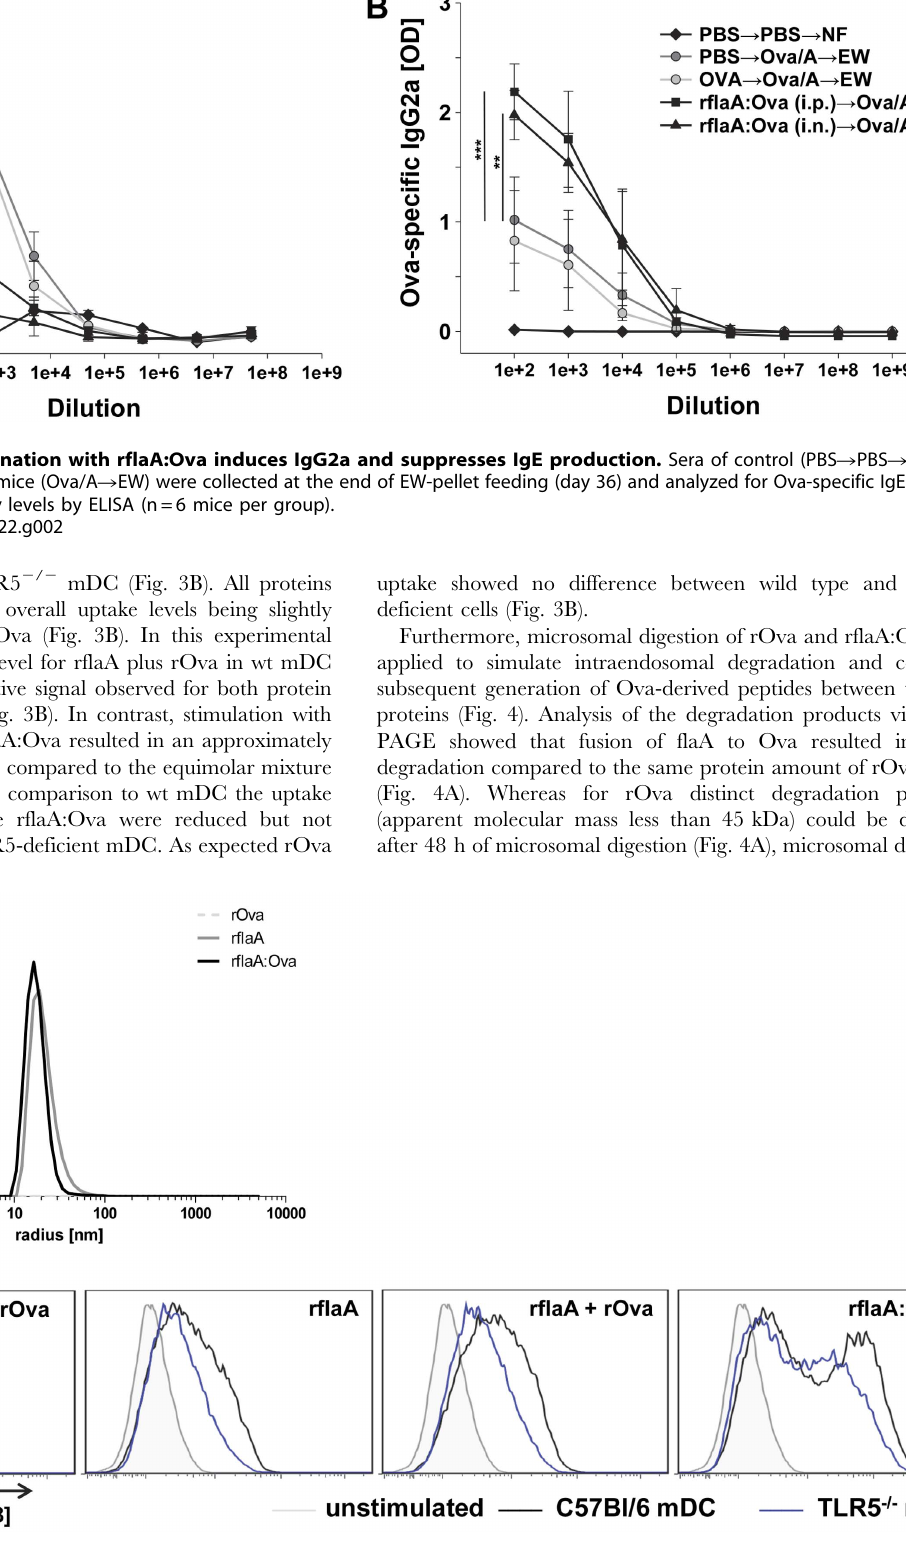
Figure 3. rflaA:Ova forms aggregates which are efficiently internalized by mDC. Hydrodynamic radii of rOva, rflaA and rflaA:Ova were determined via lightscattering ( A ). Uptake of Alexa Flour 488 labelled proteins into C57Bl/6 wt (black) and TLR5 2 / 2 (blue) CD11c + CD11b + B220 - mDC stimulated with rOva (1 m g/ml), rflaA (0.7 m g/ml), rflaA (0.7 m g/ml) + rOva (1 m g/ml) or rflaA:Ova (1.7 m g/ml) was quantified 15 min post stimulation via flow cytometry ( B ).